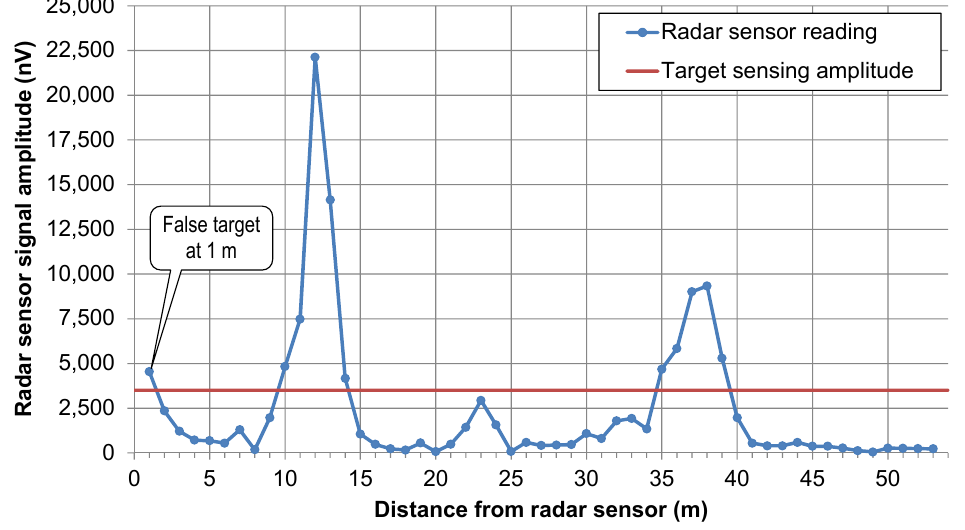
Figure 10. Target sensing level: problem of sensing the driving surface.